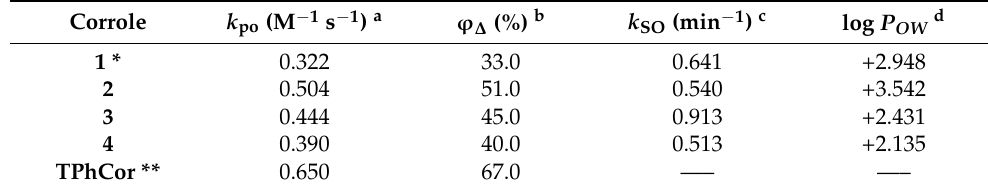
Table 4. Photobiological parameters of corroles 1 – 4